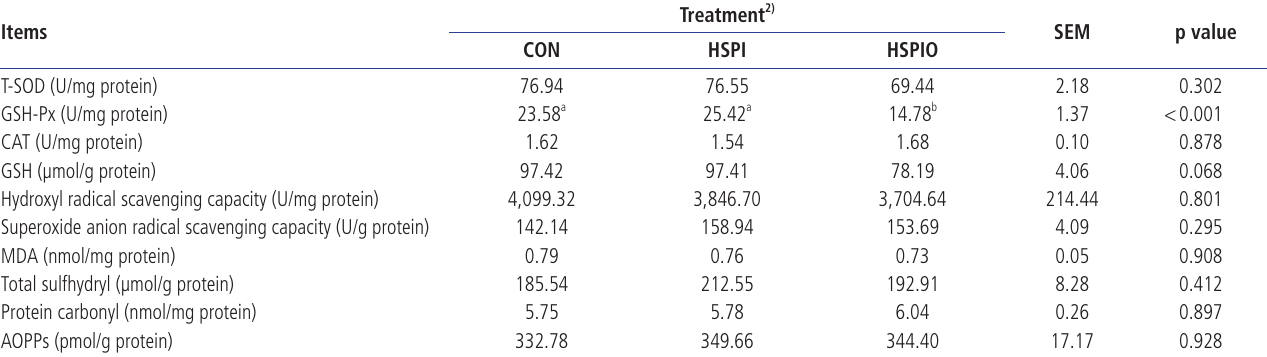
Table 7. Duodenal mucosa antioxidant indices and oxidation products contents of broilers fed basal diet, heat-oxidized SPI diet or heat-oxidized mixture of SPI and 2% soybean oil diet 1)